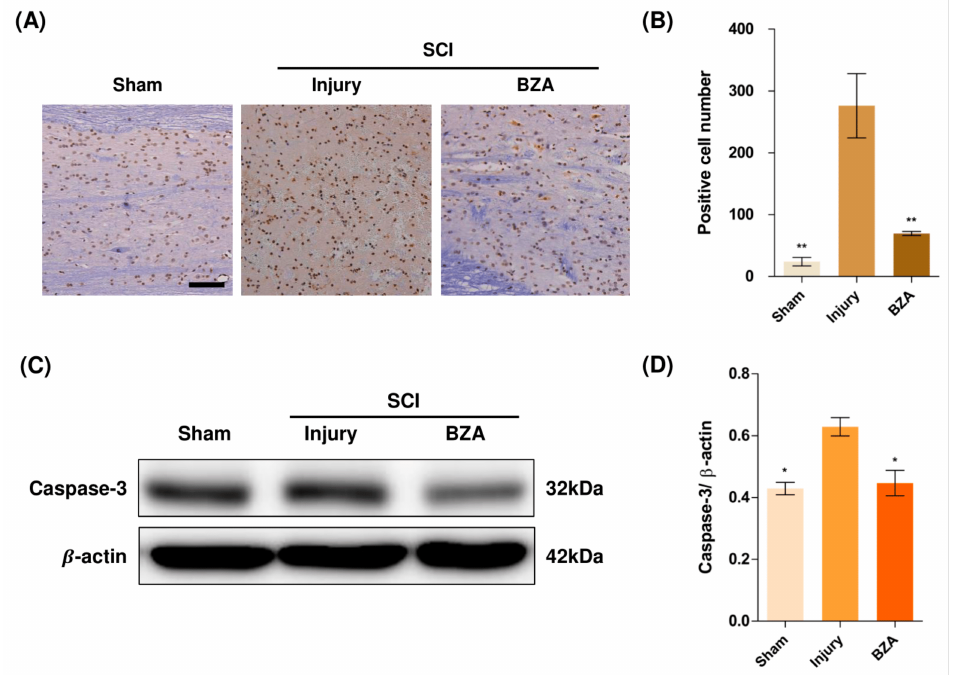
Figure 4. BZA attenuates caspase-3-induced apoptosis activity after SCI and suppresses the inflam- matory response. ( A ) Representative images of the TUNEL assay observed in each group of spinal cord samples to examine apoptosis activity. ( B ) Graph result for positive cell number by quantitative analysis of TUNEL assay. To confirm the activity against apoptosis, western blot for caspase 3 was performed. ( C ) Representative images of western blot results for caspase 3 in the sham, injury, and BZA groups. ( D ) The graph of caspase 3 was measured to quantify the western blot results . All results of the graph confirmed the significance between the injury group and all other